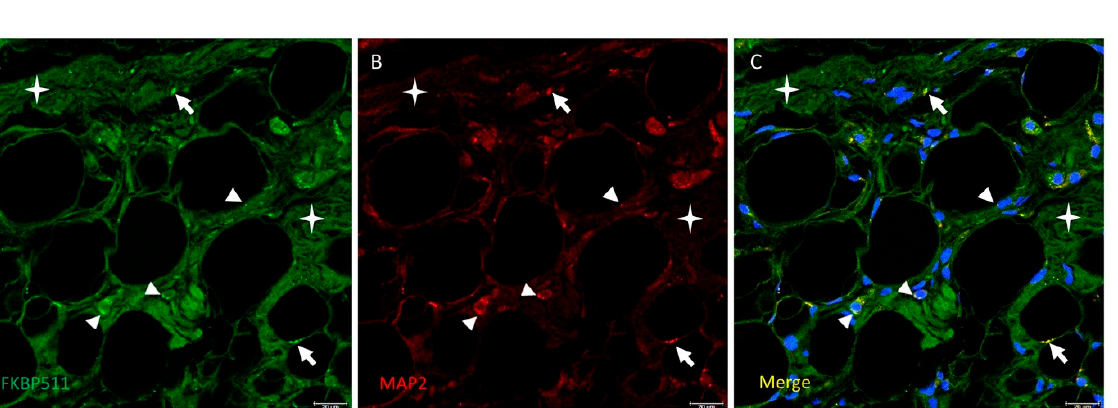
Figure 6. Double immunolabelling for FKBP51 (panel A , green) and the microtubule-associated protein 2 (MAP2, panel B , red) in Hoffa’s fat pad tissue sections from a patient with advanced knee osteoarthritis (grade IV). Panel C : co-staining of FKBP51+/MAP2+ as interspersed dots (arrows), a high number of them passing close to the perinuclear zone of adipocytes (arrowheads). Stars are placed in connective tissue.